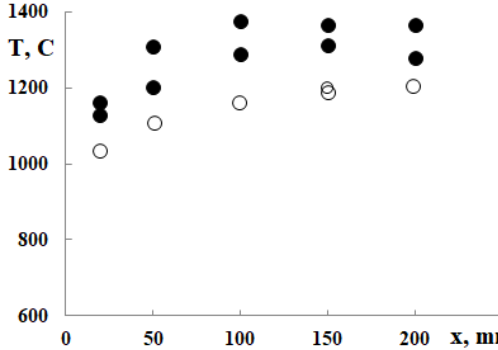
Figure 9. The axial temperature distributions in the operating plasma-chemical reactor worked with: white dots—zeolites, and black—clay. The air flow through the plasma torch was 1 g/s, and the protective gas flow rate was 2.63 g/s. The PT power was 41 kW.